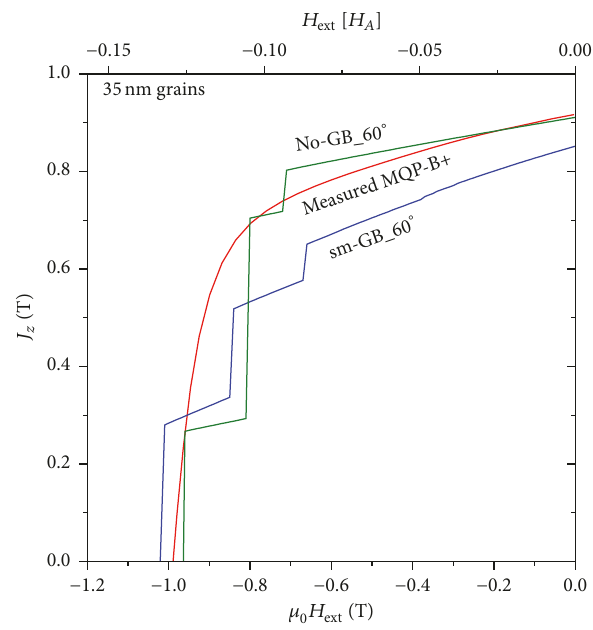
Figure 10: Comparison of the measured demagnetization curve of the MQP-B+ melt-spun ribbon with calculated curves for directly coupled Nd 2 Fe 14 B grains (no-GB) and grains separated by a weakly soft magnetic GB-phase (sm-GB) with 𝐽 𝑠 = 1.1 T and 𝐴 = 6.54 pJ/T for an average grain misorientation of 60 ∘ . The average grain size is 35 nm and the average GB thickness is